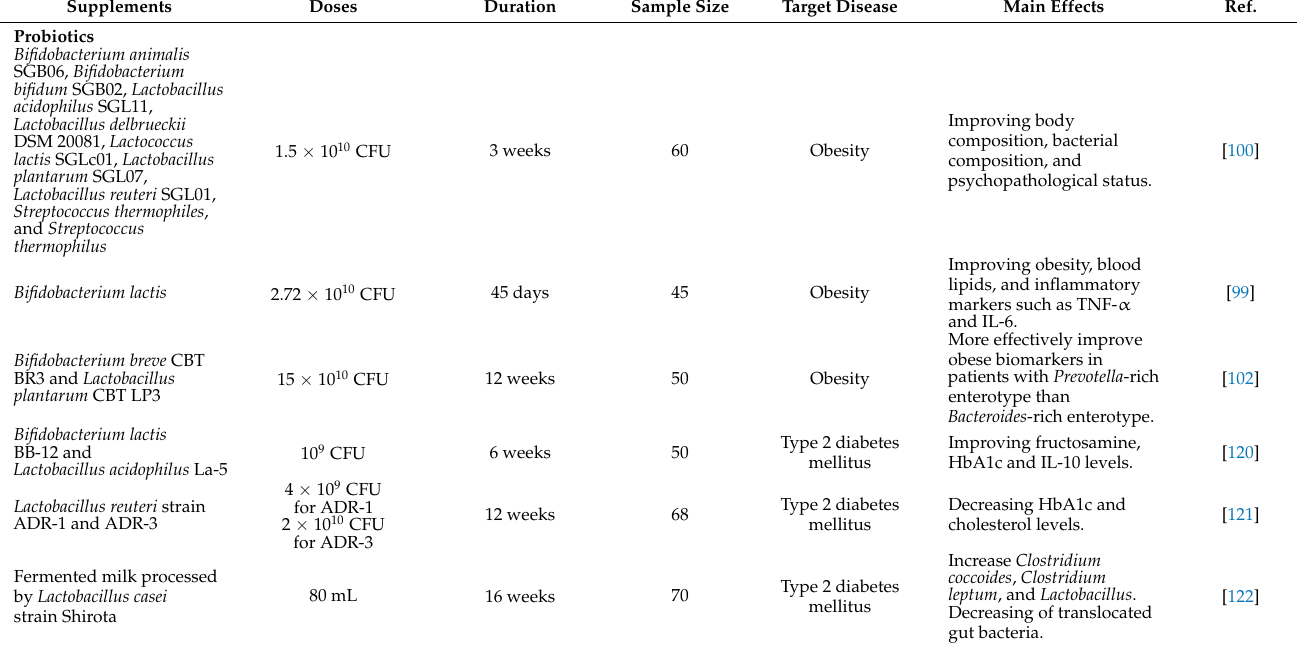
Table 2. The clinical effects of probiotics, prebiotics, synbiotics, and postbiotics on metabolic